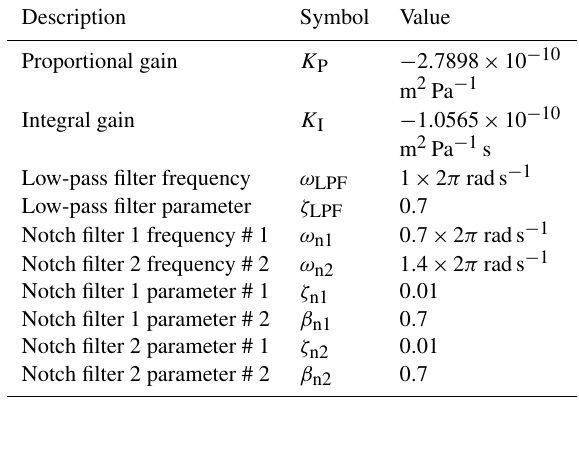
Table 1. Controller parameters of the spear valve augmented con-